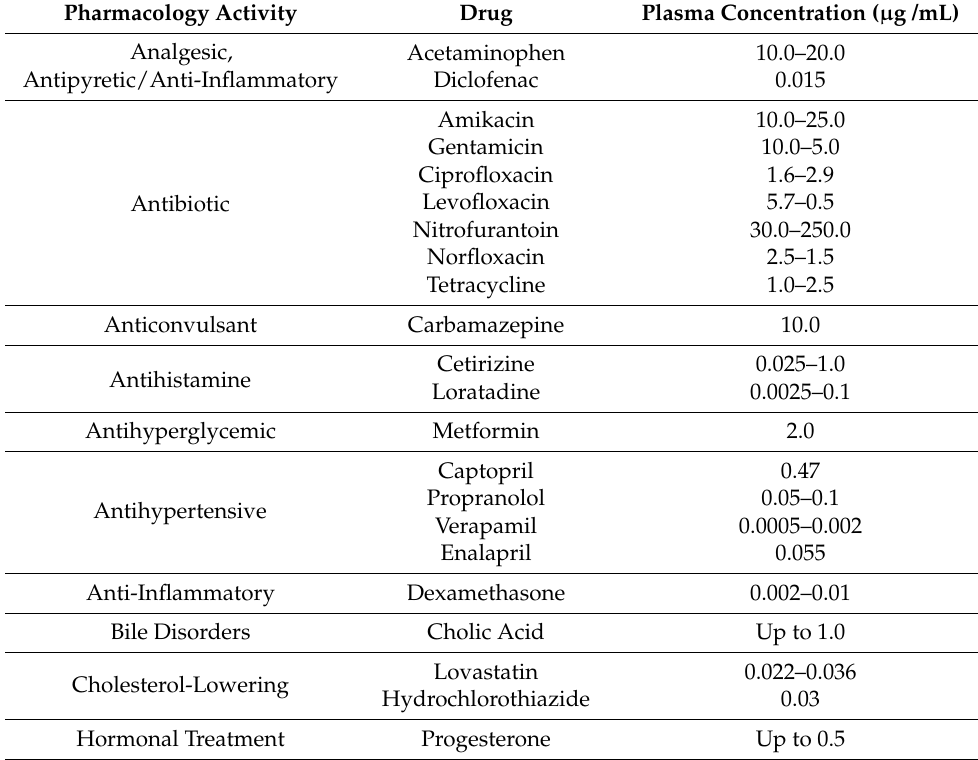
Table 1. Plasma concentration of each drug and its pharmacological